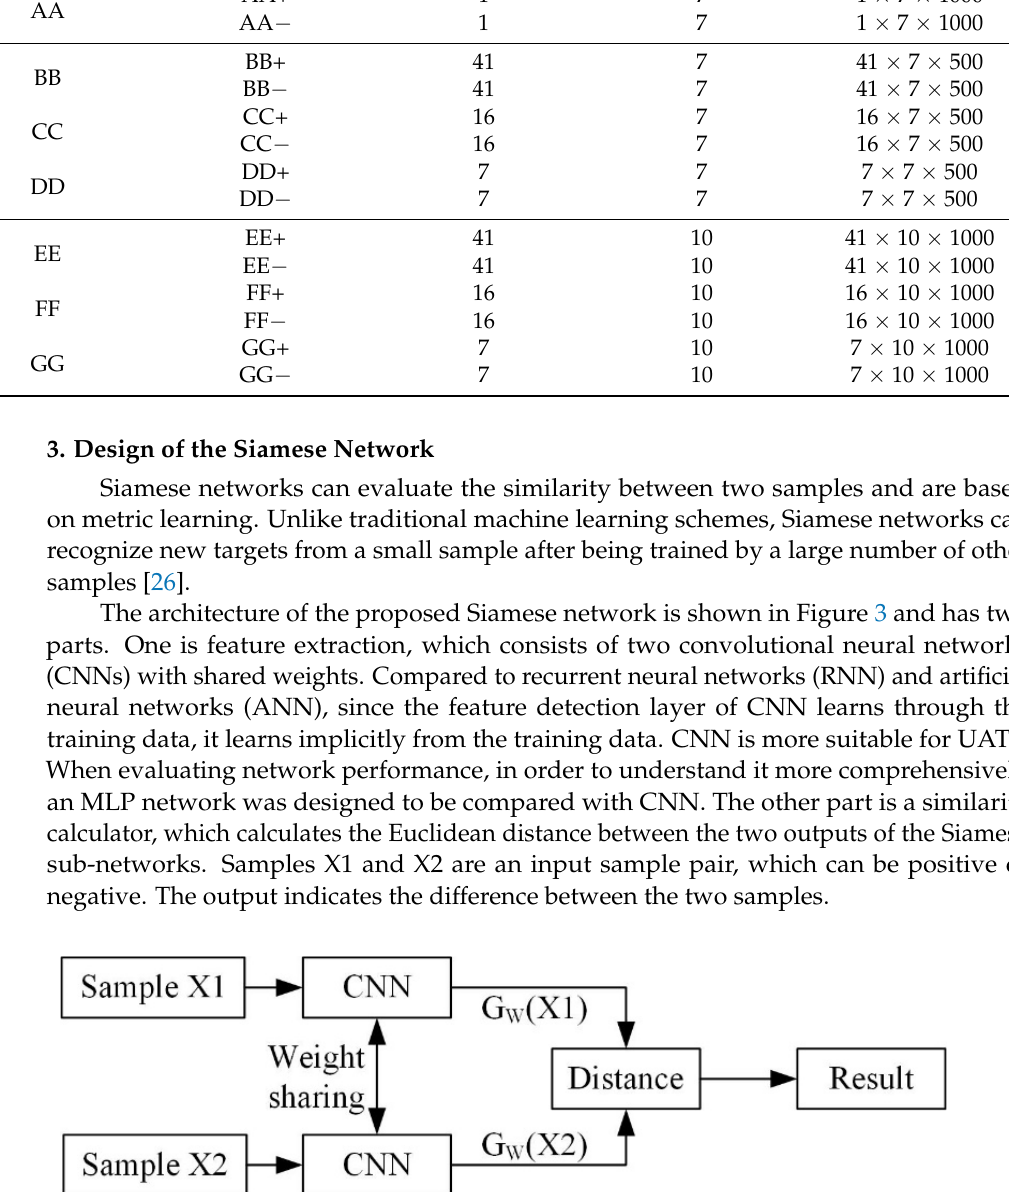
Table 2. The dimensions of positive and negative sample pairs .